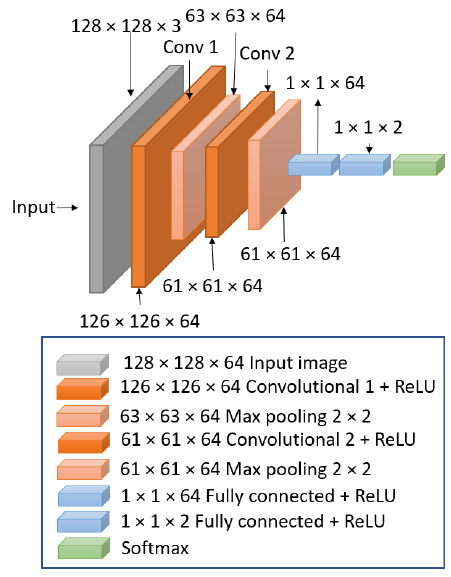
Figure 8. Convolutional Neural Network Architecture.